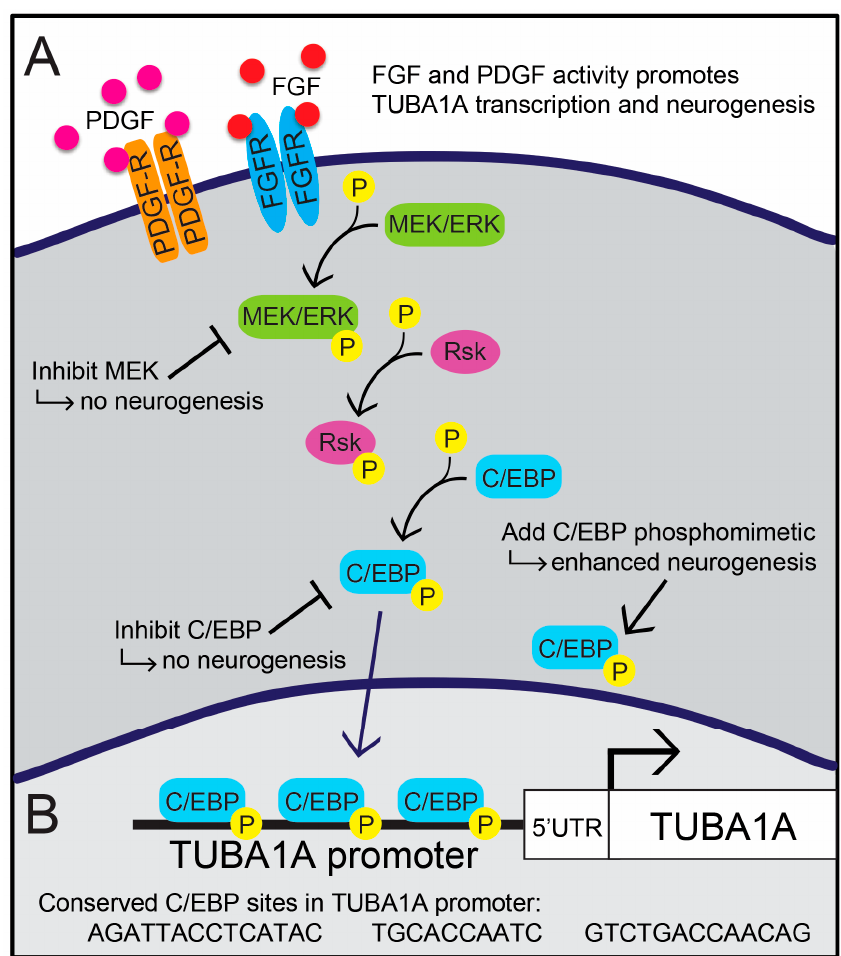
Figure 5. Transcriptional regulation of TUBA1A in mouse cortical progenitors. ( A ) FGF/PDGF treatment of cortical progenitors leads to a phosphorylation cascade activating MEK/ERK, Rsk, and C/EBP; and ( B ) in the nucleus, phosphorylated C/EBP directly binds three conserved C/EBP binding sites in the TUBA1A promoter, leading to transcription of TUBA1A and neurogenesis. Based on data from [153].